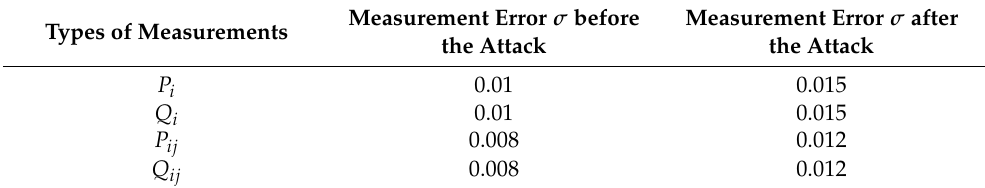
Table 3. The measurement error before and after the power system was